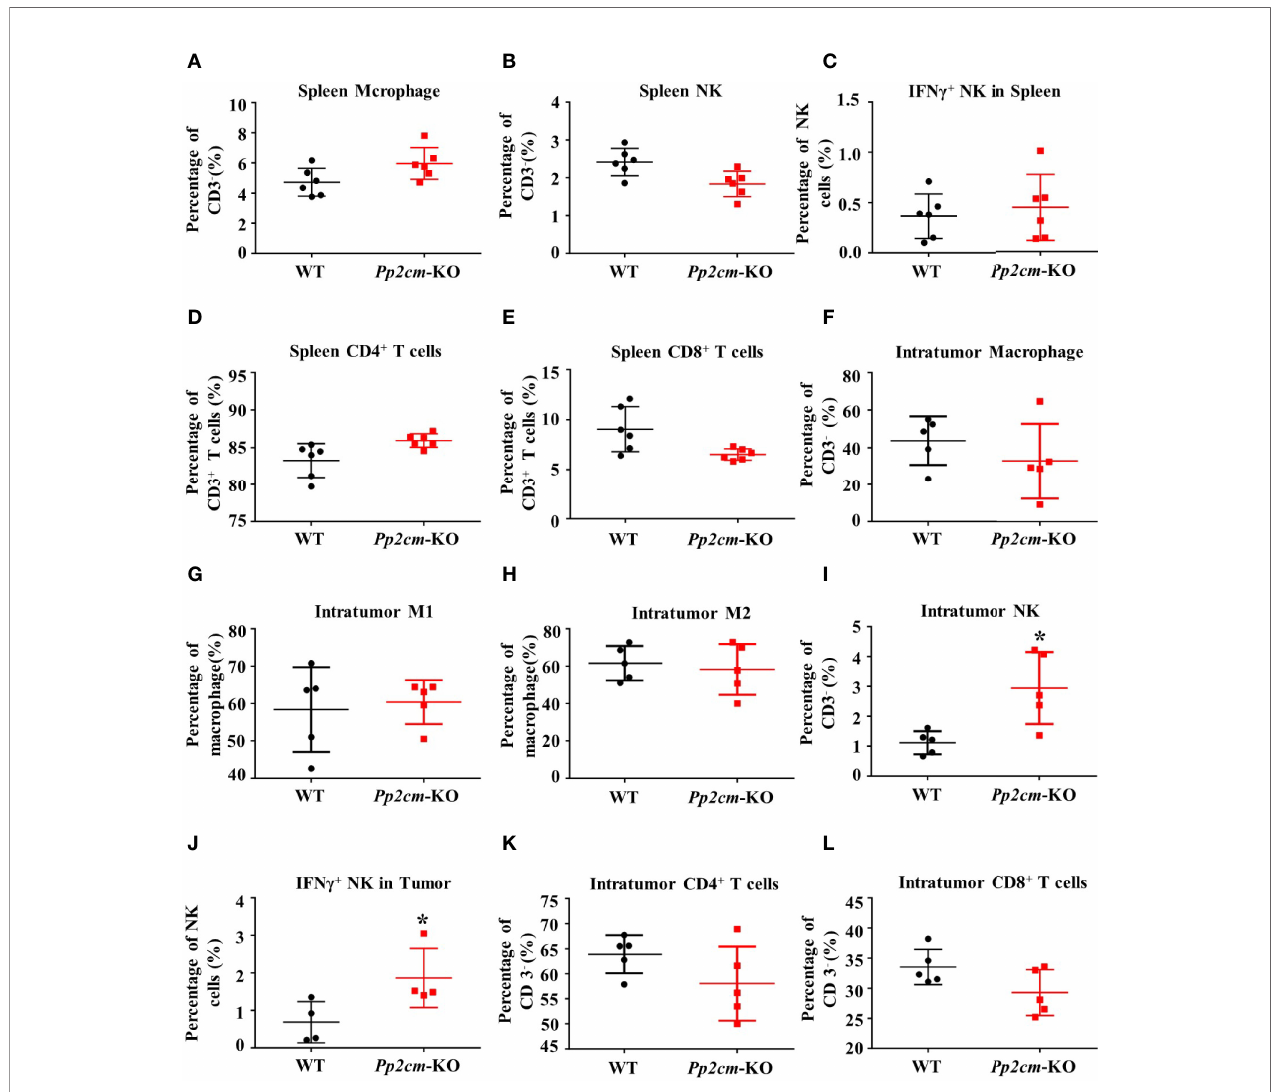
FIGURE 3 | High BCAA enhances NK cell immune function in tumor-bearing mice. (A – E) Flow cytometry was used to analyze the percentage of immune cells including macrophage, NK cell, IFN- g + NK cell, CD4 + T cell, and CD8 + T cell in spleen. (F – L) Flow cytometry was used to analyze the percentage of intratumor macrophage, type-I macrophage, type-II macrophage, CD4 + T cell, CD8 + T cell, NK cell, and IFN- g + NK cell. Mean ± SD, *p < 0.05. Student ’ s